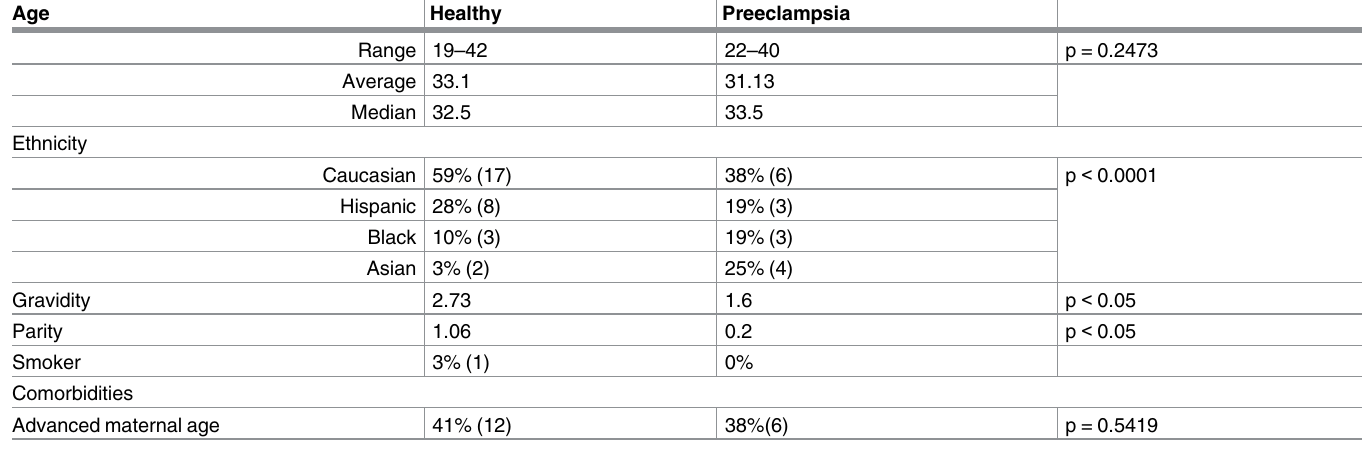
Table 1. Subject demographics for immunophenotype. Age, gravidity, and parity differencesanalyzedwith a two-way Student’sT test. Ethnicity and advancedmaternal age differencesanalyzedusing a Fisher’s exact test.